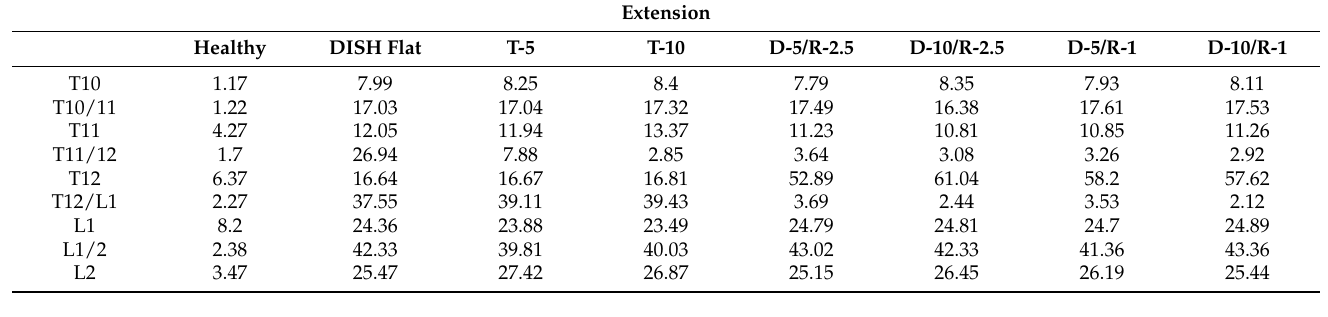
Figure 5. The highest value for maximum von Mises stress on the vertebral body and intervertebral disc (MPa) in extension. The vertical axis is stress (MPa), and the horizontal axis is each vertebral body and intervertebral level.